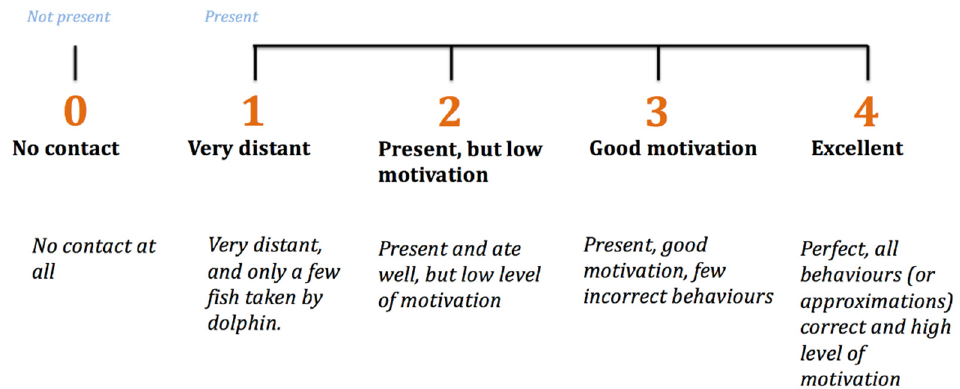
Figure 3. Five-point Likert scale (from [64]) used by trainers to score each dolphin’s willingness to participate ( WtP ) in daily training sessions over the 8-week period of the study.